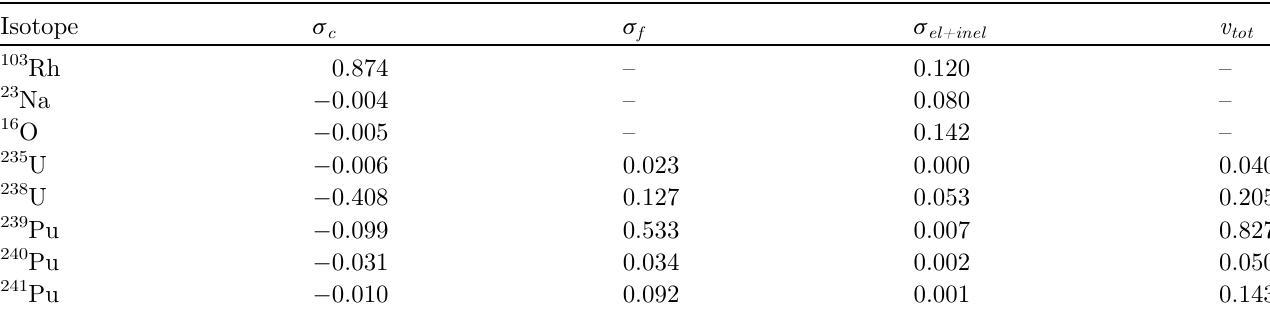
Table 5. Sensitivity coef fi cients (in %/%) on D r Isotope